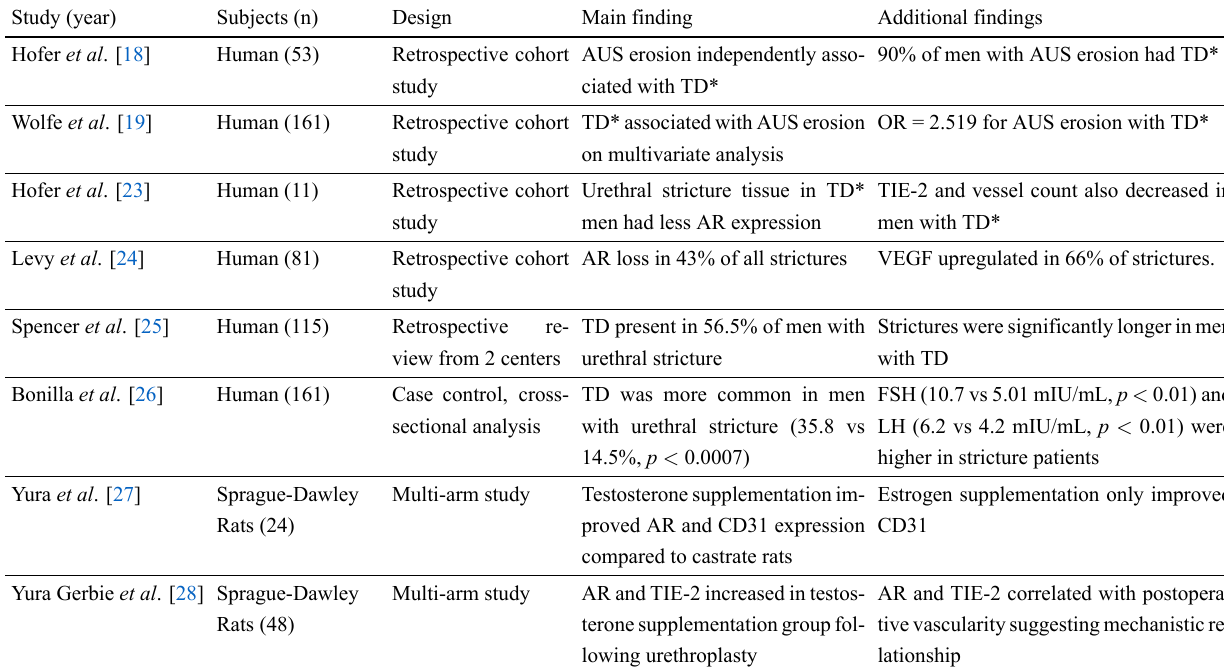
Table 1. Summary to studies evaluating testosterone and urethral